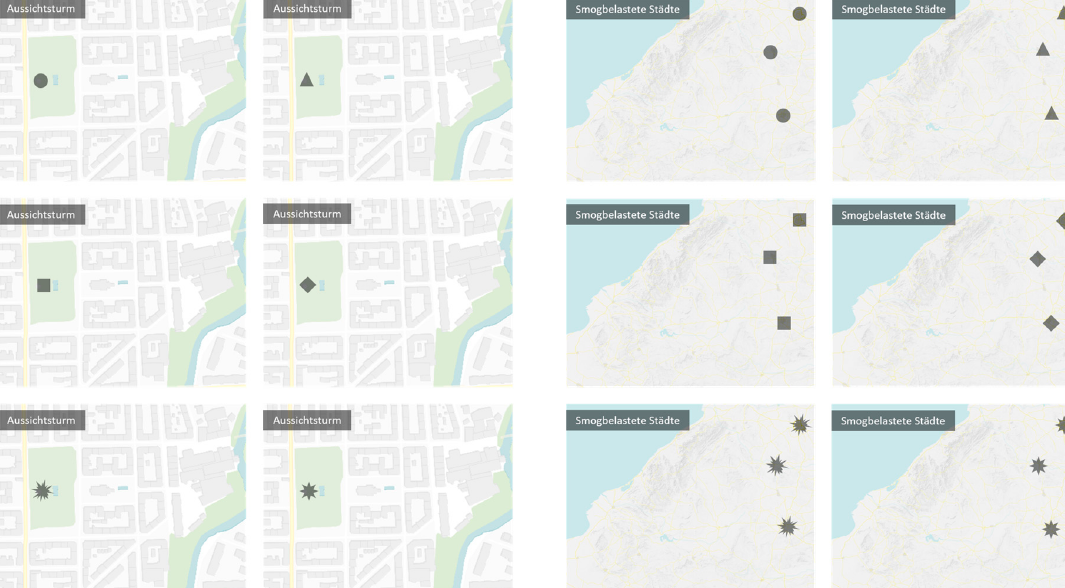
Figure 1. Examples of two map sets. Left map set: locating a “Lookout tower” by one-point symbol per map. Right map set: locating “Smog polluted cities” by three symbols on each map.